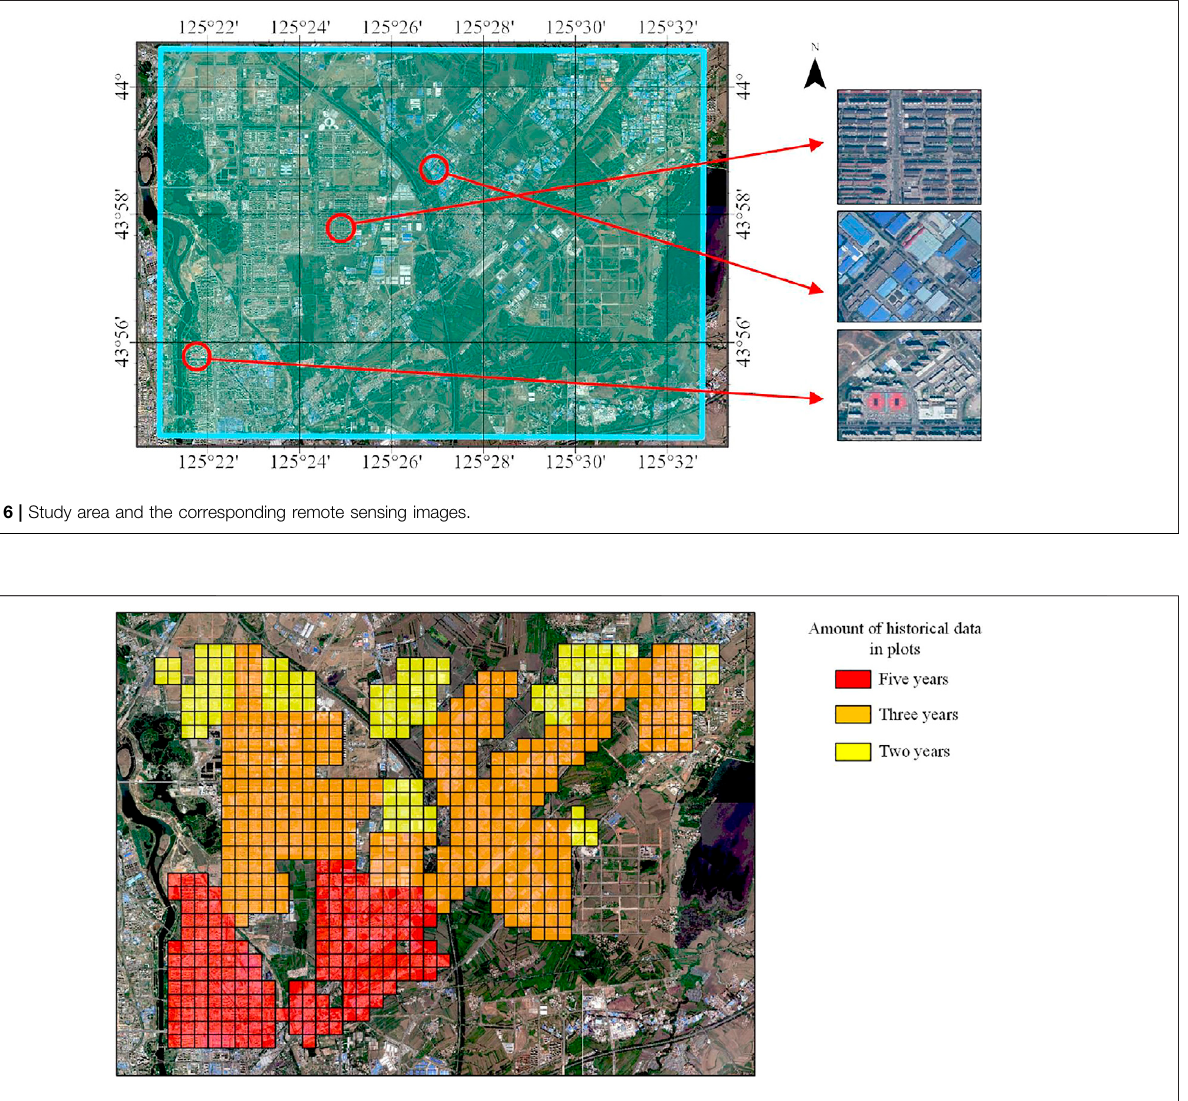
FIGURE 7 | Plots and amount of historical